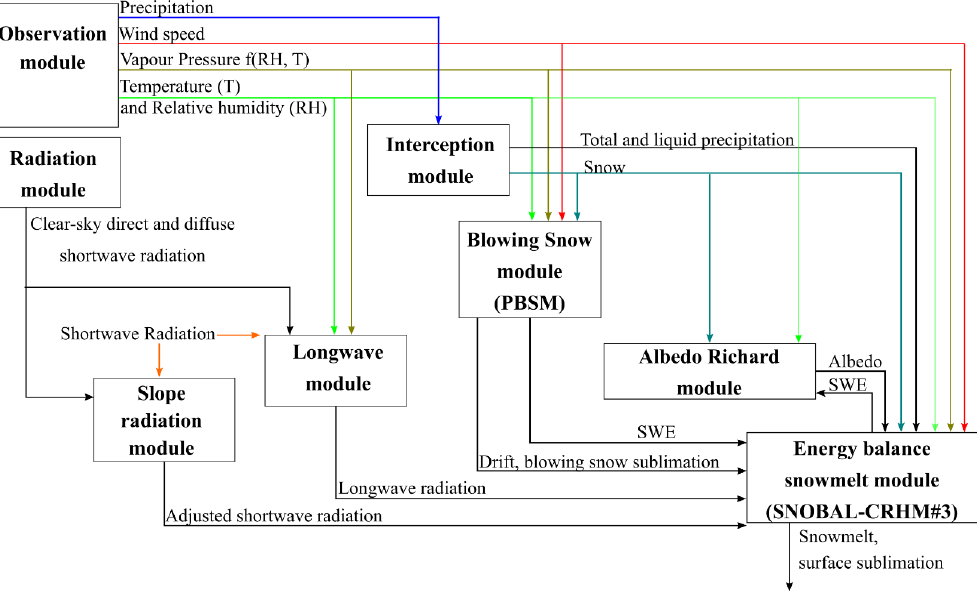
Figure 3. Flowchart of the interaction of state variables and fluxes calculated by physically based hydrological process modules using CRHM. All the above modules are currently available in the CRHM platform.